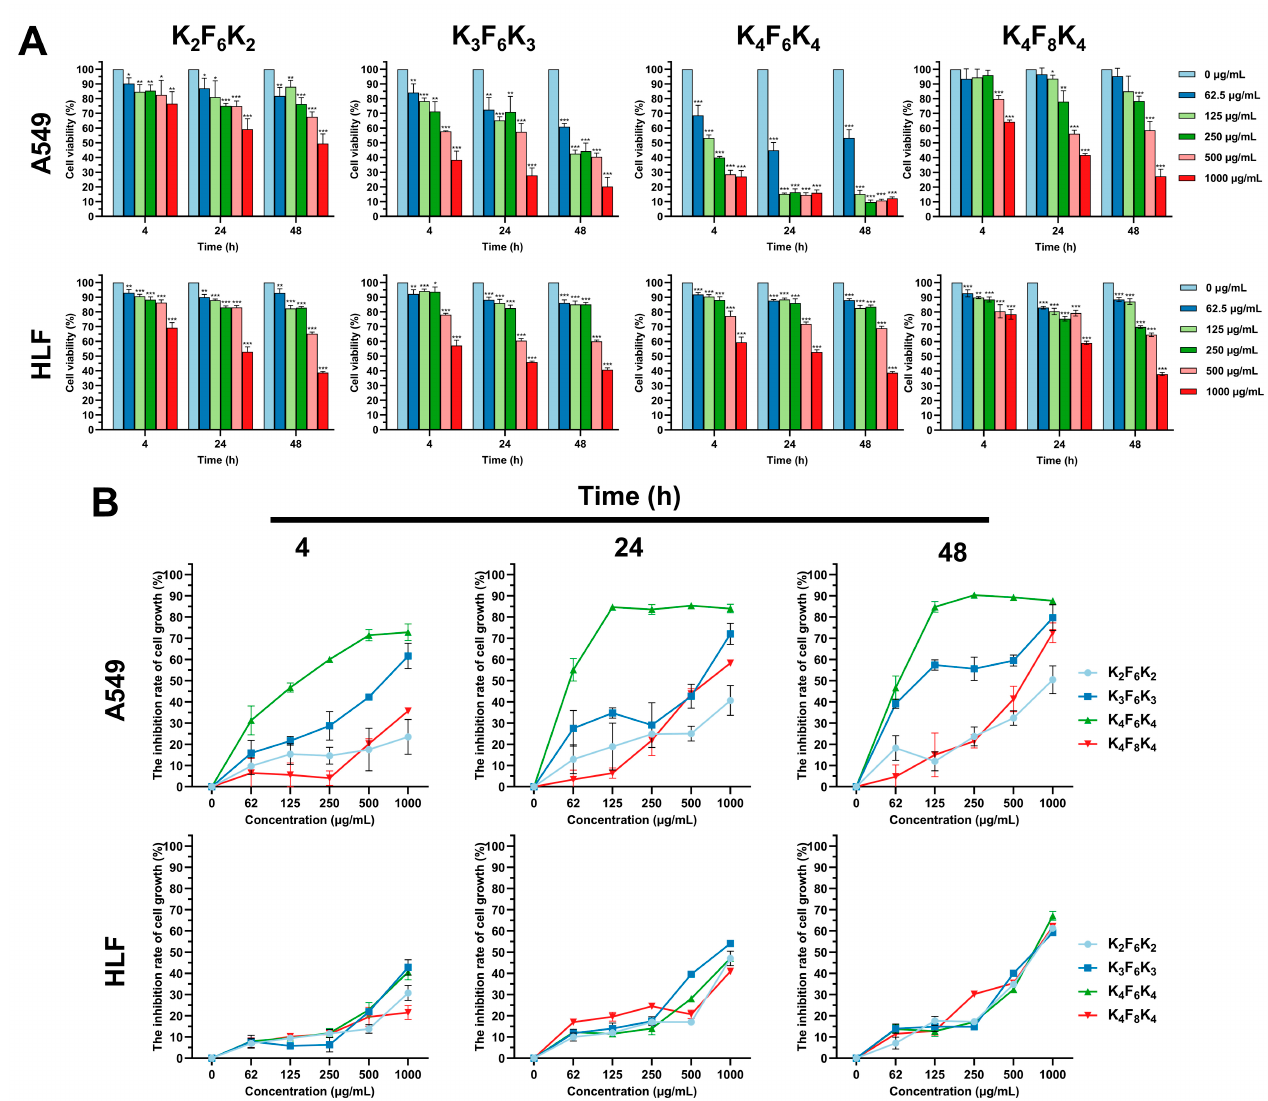
Figure 1. Preferential cytotoxicity of the triblock amphiphilic short AMPs (K n F m K n : K 2 F 6 K 2 , K 3 F 6 K 3 , K 4 F 6 K 4 , and K 4 F 8 K 4 ) with different concentrations (0, 62.5, 125, 250, 500 and 1000 µ g/mL) for 4, 24 and 48 h against A549 cells by CCK-8, with HLF as the negative control. ( A ) Cell viability rate of A549 and HLF cells after being treated with K n F m K n ; ( B ) The inhibition rate of A549 and HLF cell growth after being treated with K n F m K n . Data are expressed as the mean ± standard deviation.